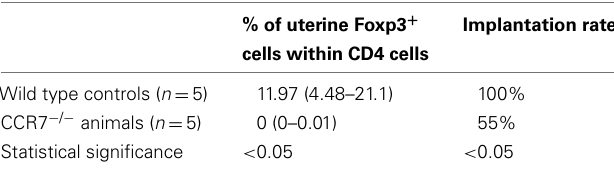
Table 1 | Consequences of CCR7 deficiency in number of uterineTregs and implantation